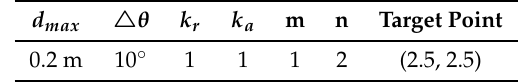
Table 1. The experimental parameters in a static